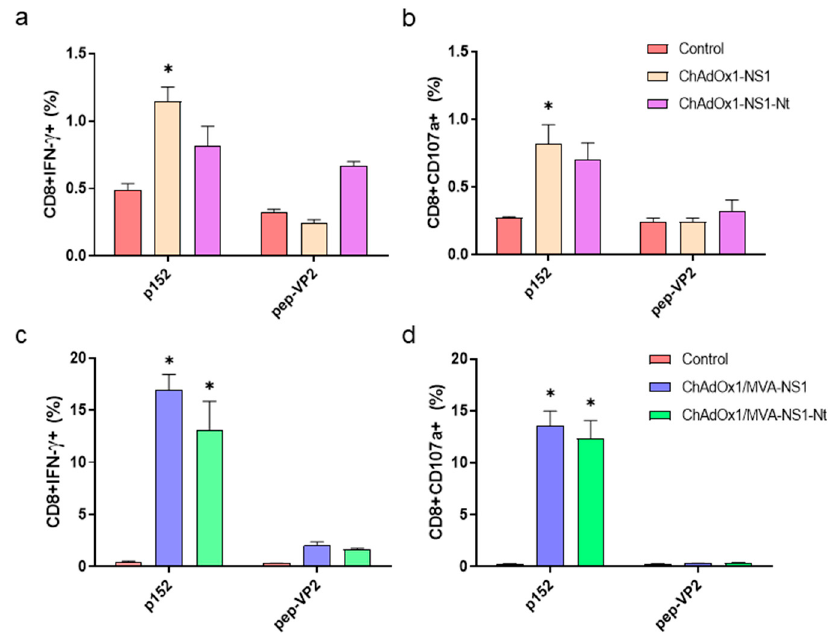
Figure 5. Cellular immune responses against BTV in immunized mice. IFNAR(- / -) mice were non-immunized or immunized with a single dose of ChAdOx1-NS1 or ChAdOx1-NS1-Nt ( a , b ), or following a heterologous prime-boost of ChAdOx1 / MVA-NS1 or ChAdOx1 / MVA-NS1-Nt ( c , d ). Four weeks post-immunization (prime-only) or two weeks after boosting with the appropriate MVA (prime-boost), spleens were harvested and splenocytes were stimulated with 10 µ g / mL of p152 (immunodominant peptide from NS1 protein), with 10 µ g / mL of a non-relevant peptide from protein VP2 (pep-VP2) protein, or left untreated in RPMI medium. Intracellular staining of IFN- γ ( a , c ) or CD107a ( b , d ), in CD8 + T cells was analyzed by flow-cytometry. Graphs show the percentage of CD8 + IFN- γ + or CD8 + CD107a + lymphocytes. Bars represent the mean values of each group and error bars represent standard error of the mean (SEM). Asterisks denote significant di ff erences between stimulated splenocytes of immunized and control mice ( p < 0.05) (The Mann–Whitney U test). Gate was set making use of double-negative splenocytes corresponding to non-immunized mice exposed to RPMI medium. * p -value < 0.05.